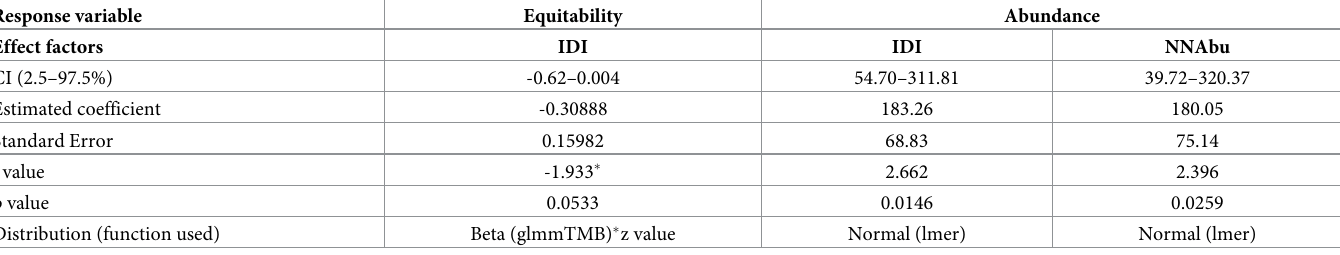
Table 4. Effects of the Integrated Disturbance Index (IDI), and numeric abundance proportion of non-native fish species (NNAbu) on the metrics of fish assem- blage’s structure evaluated in the Generalized Linear Mixed Models